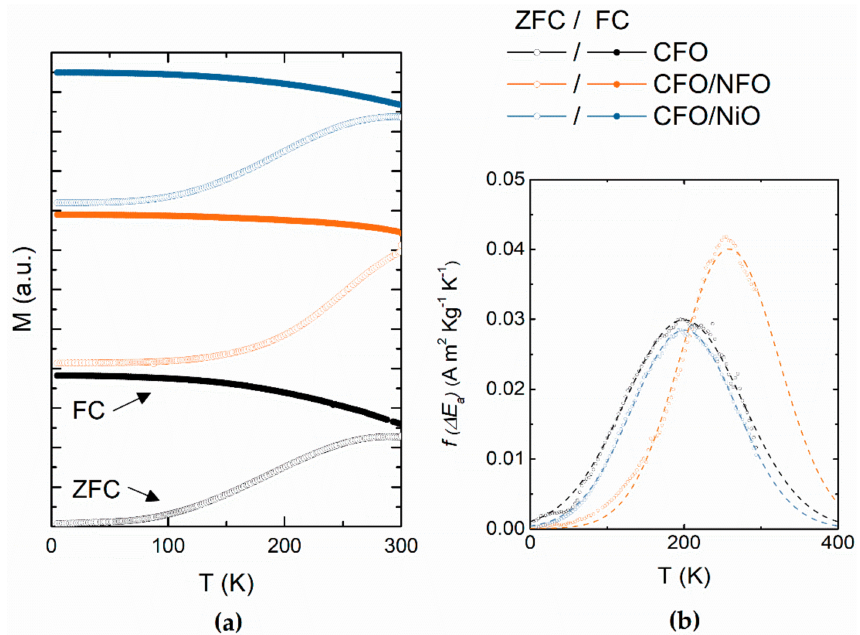
Figure 2. ( a ) Zero-field cooling and field cooling (ZFC/FC) magnetizations recorded in 2.5 mT measuring field; ( b ) distribution of magnetic anisotropy energy: measured (dots) and extrapolated by fit with the normal function (dashed lines). Table 2. Mean value of blocking temperature (<T B >) and its dispersion ( σ MAG ), saturation